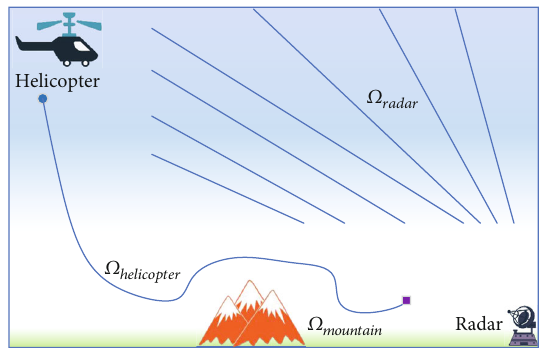
Figure 1: Illustration of the complex battle fi eld